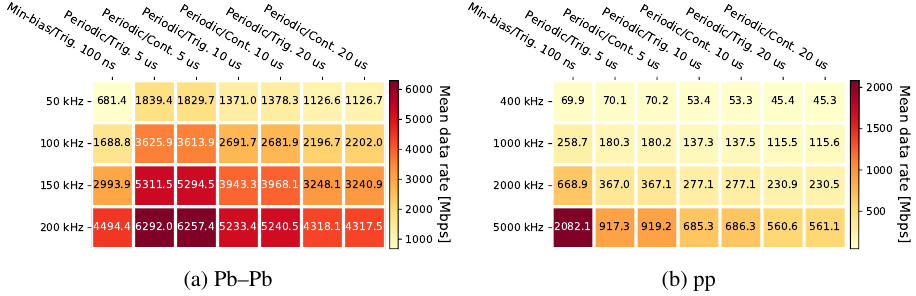
Figure 6: Data rates per stave / RU in layer 0 for all Pb–Pb and pp simulations. The readout e ffi ciency in terms of readout frames, at 100 kHz and 200 kHz Pb–Pb, is